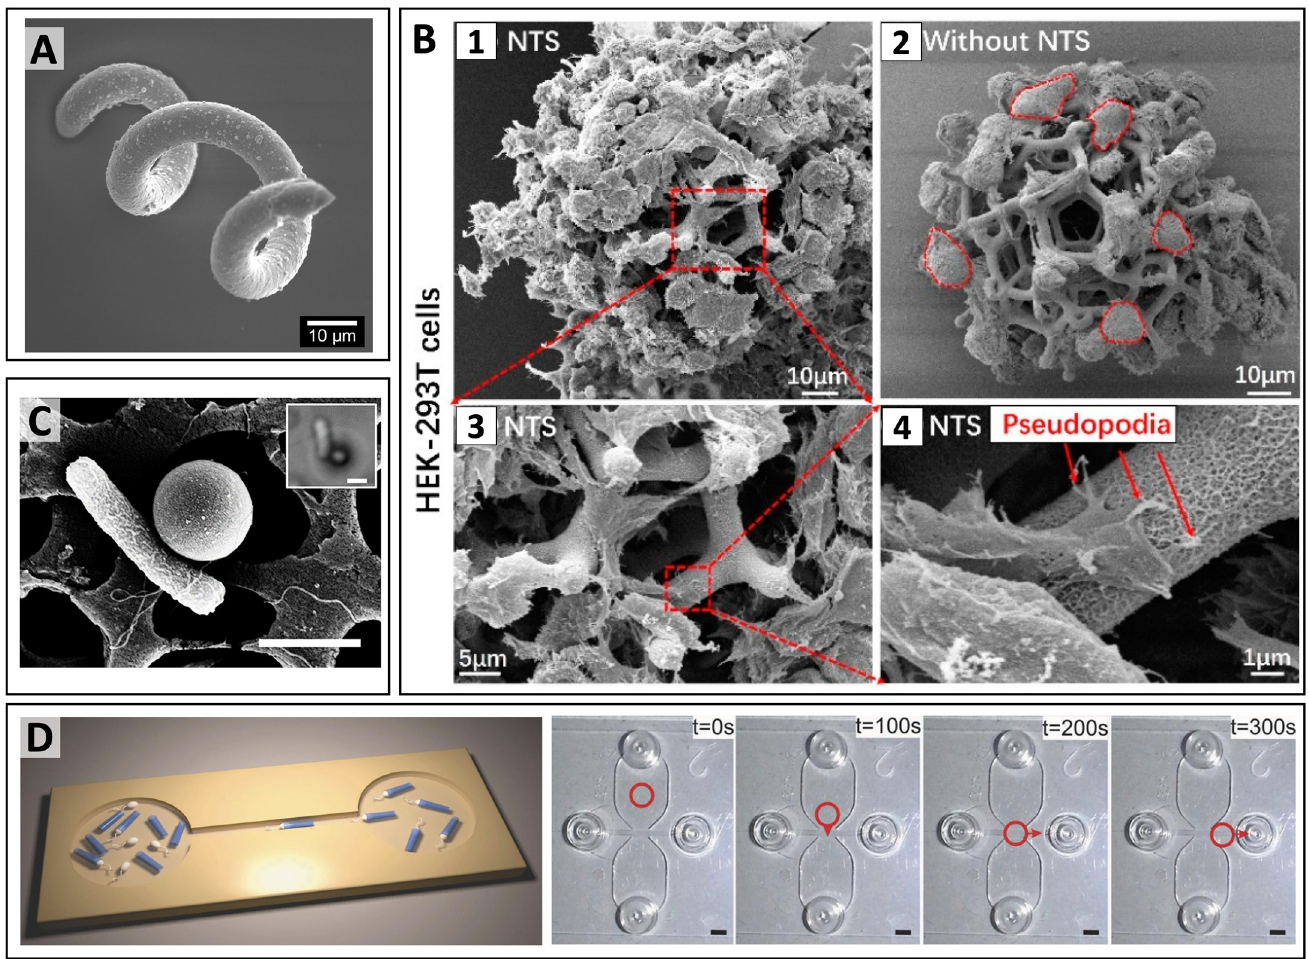
Figure 9. Magnetic microrobots. ( A ) SEM image of Spirulina-templated magnetic helical microswimmers. Adapted and Reproduced with permission from Ref. [308]; ( B ) Cell-carrying magnetic microrobots with bioactive nanostructured titanate surface for enhanced cell adhesion. SEM image of HEK-293T cells on microrobot after 1 day of incubation with (B1) and without (B2) nanostructured titanate surface; (B3) high-magnification SEM image of HEK-293T cells on microrobot with NTS; (B4) High-magnification SEM image of single HEK-293T cell with protrusive pseudopodia on microrobot with NTS. Adapted and Reproduced with permission from Ref. [325]; ( C ) Bacteria-driven microswim- mers for targeted active drug delivery. Adapted and Reproduced with permission from Ref. [330]; ( D ) Magnetic guidance of microrobots based on sperm cells from a chamber containing a mixture of microtubes and sperm cells (left chamber) into a clean chamber (right) of an ibidi-chip. Scale bar: 3 mm. Adapted and reproduced with permission from Ref.